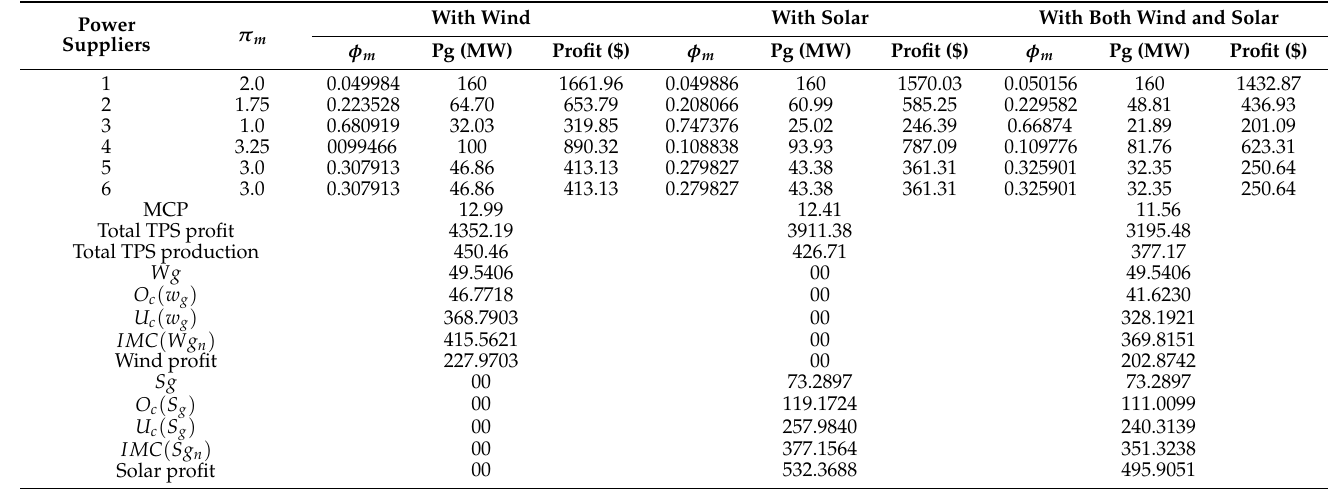
Table 8. Results for standard IEEE 30-bus system with renewable.